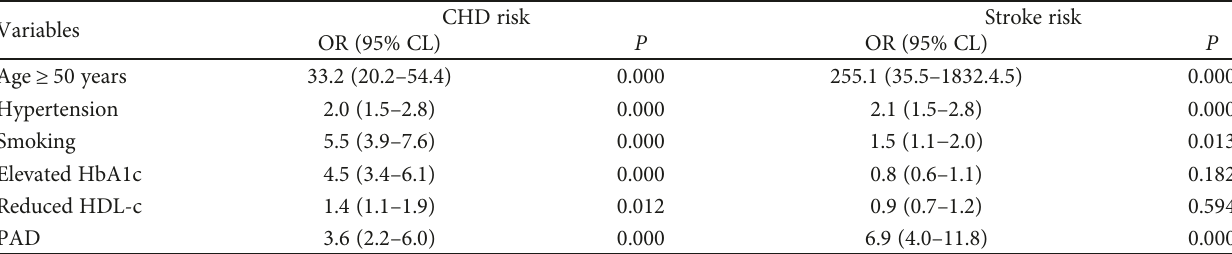
Table 4: Multivariate binary logistic regression analysis of risk factors for CHD and stroke as estimated using the UKPDS risk